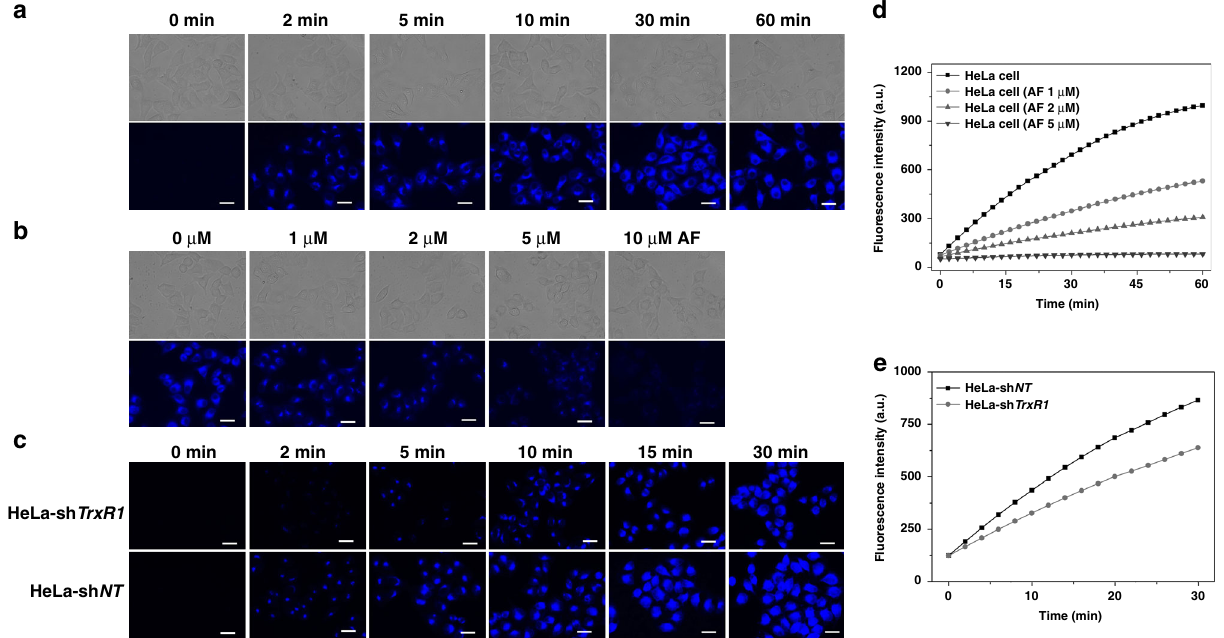
Fig. 7 Activation of Fast-TRFS in live cells. a HeLa cells were treated with Fast-TRFS (10 μ M) for the indicated times, and bright fi eld and fl uorescence images were acquired. b HeLa cells were pretreated with different concentrations of TrxR inhibitor AF for 2 h, and then were further stained with Fast-TRFS (10 μ M) for 15 min. Bright fi eld and fl uorescence images were shown. c HeLa-sh TrxR1 cells and HeLa-sh NT cells were treated with Fast-TRFS (10 μ M) for the indicated times, and fl uorescence images were shown. d Quanti fi cation of the fl uorescence intensity from ( a ) and ( b ) by a fl uorescence plate reader (Tecan In fi nite M200). e Quanti fi cation of the fl uorescence intensity from ( c ) by a fl uorescence plate reader. Scale bars: 25 μ m. Source data are provided as a Source Data fi